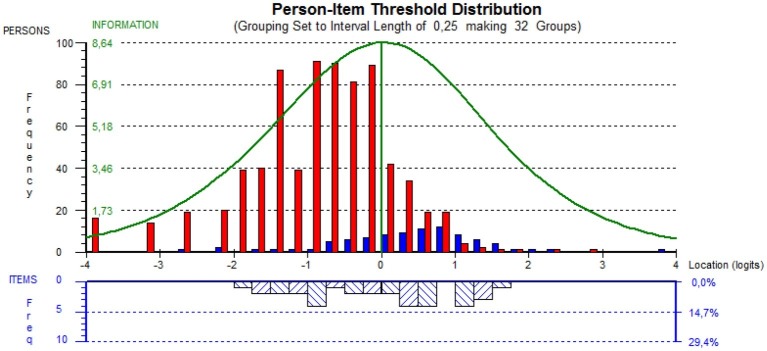
Targeting of person and item. Red bars, non-clinical; blue bars, clinical.